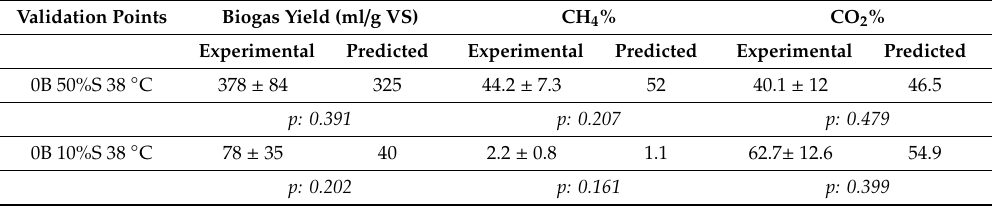
Table 18. Validation experiment results versus predicted results for AD of spent grain and pot ale